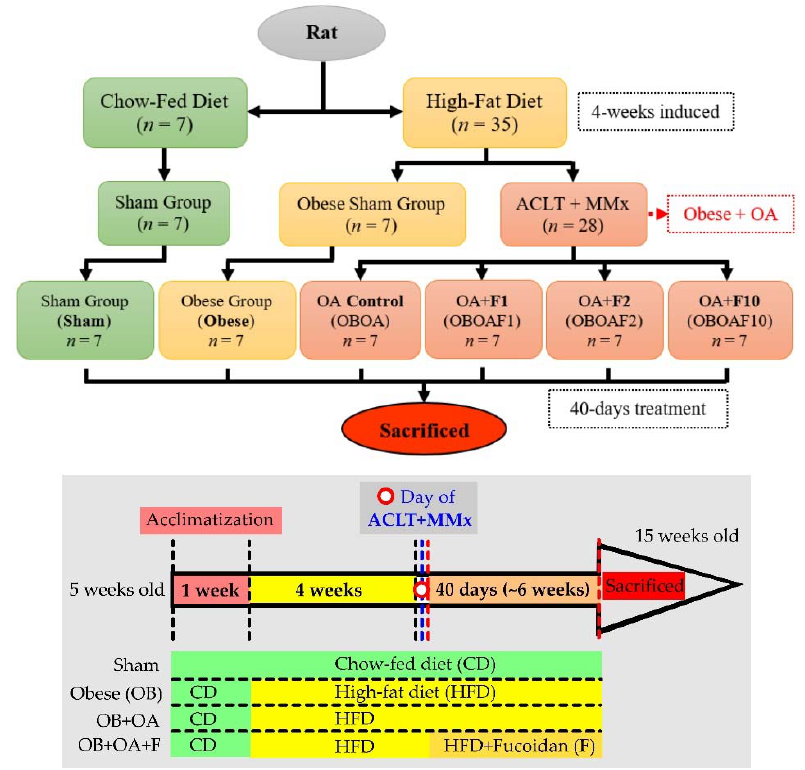
Figure 1. The flowchart of high-fat diet-induced and an anterior cruciate ligament transection and a partial medial meniscectomy (ACLT + MMx) surgery on an osteoarthritis rat model.